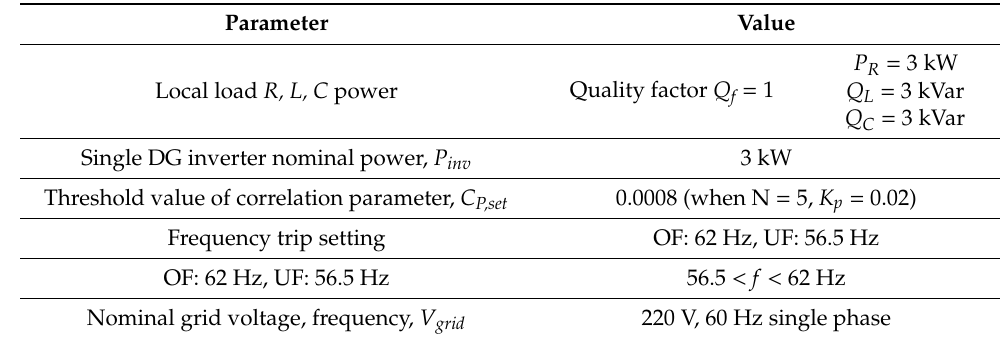
Table 2. DG’s key parameters for